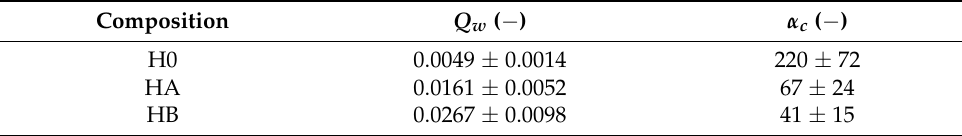
Table 6. Equilibrium swelling ( Q w ) and the degree of cross-linking ( α c